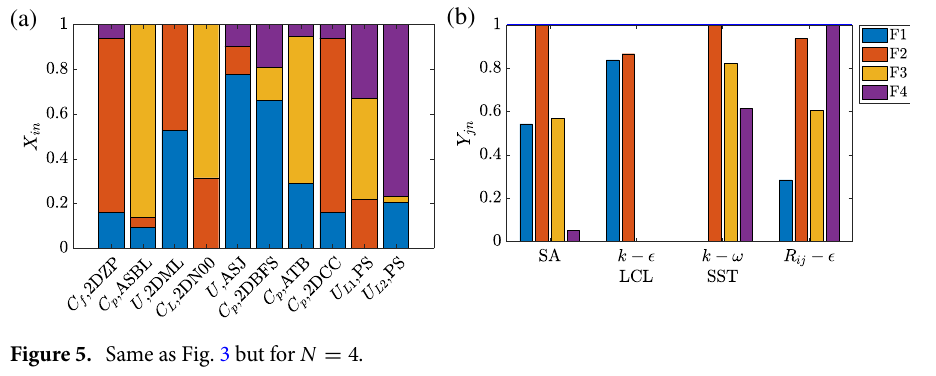
Figure 5. Same as Fig. 3 but for N = 4